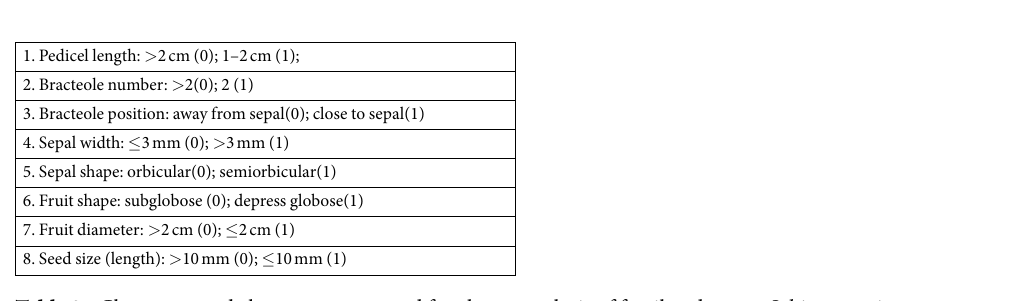
Table 2. Characters and character states used for cluster analysis of fossil and extant Schima